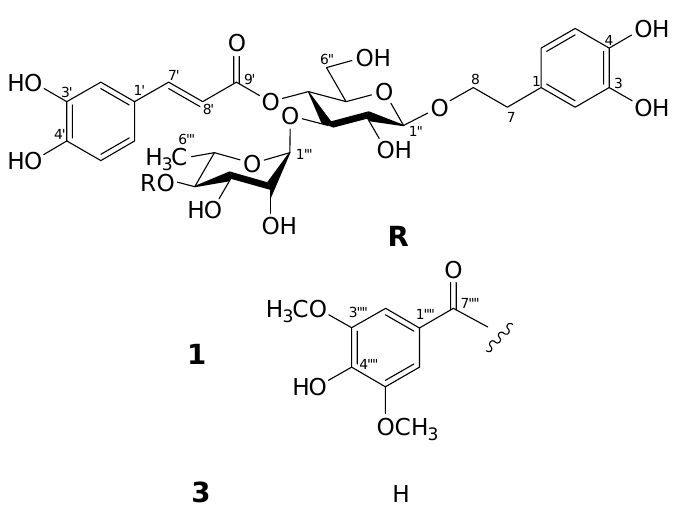
Figure 1. Structures of compounds 1 and 3